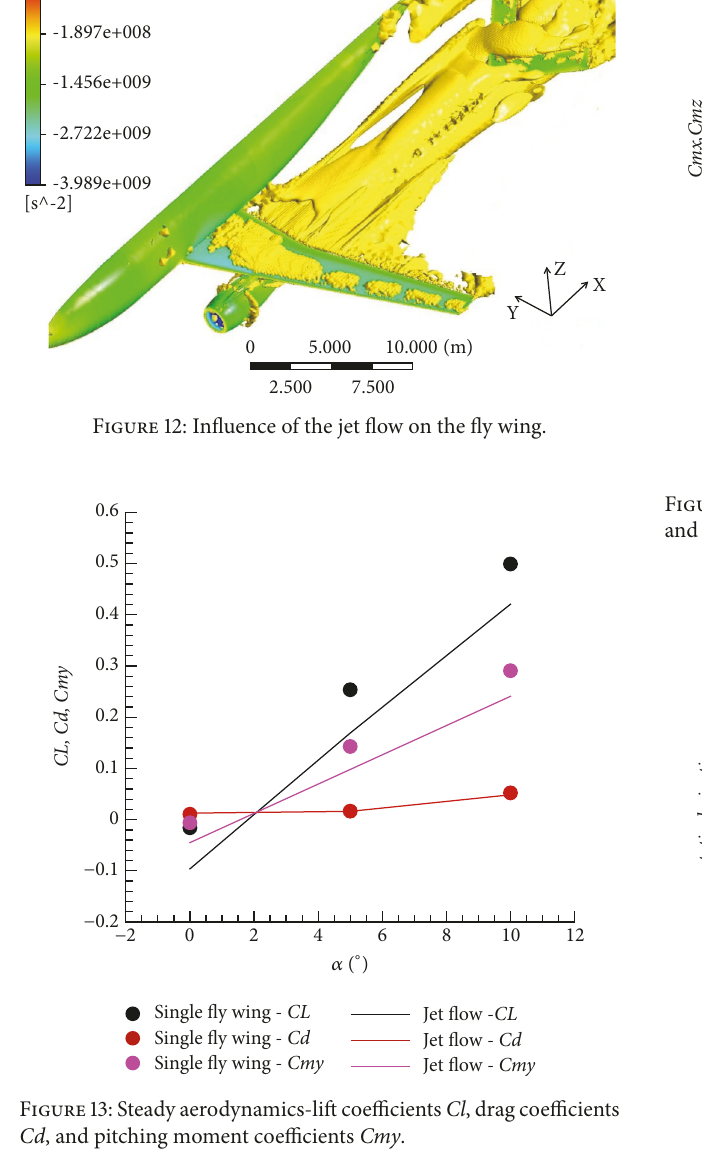
Figure 15: Static derivatives 𝐶 𝑧𝛼